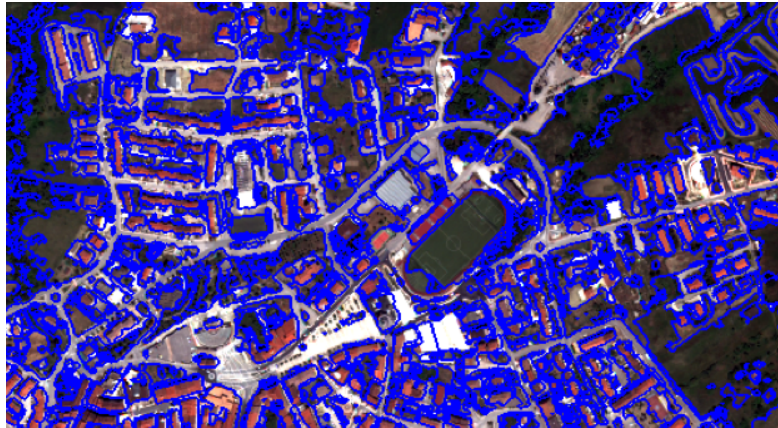
Figure 8. Result of the contrast segmentation for a first area of Lioni.